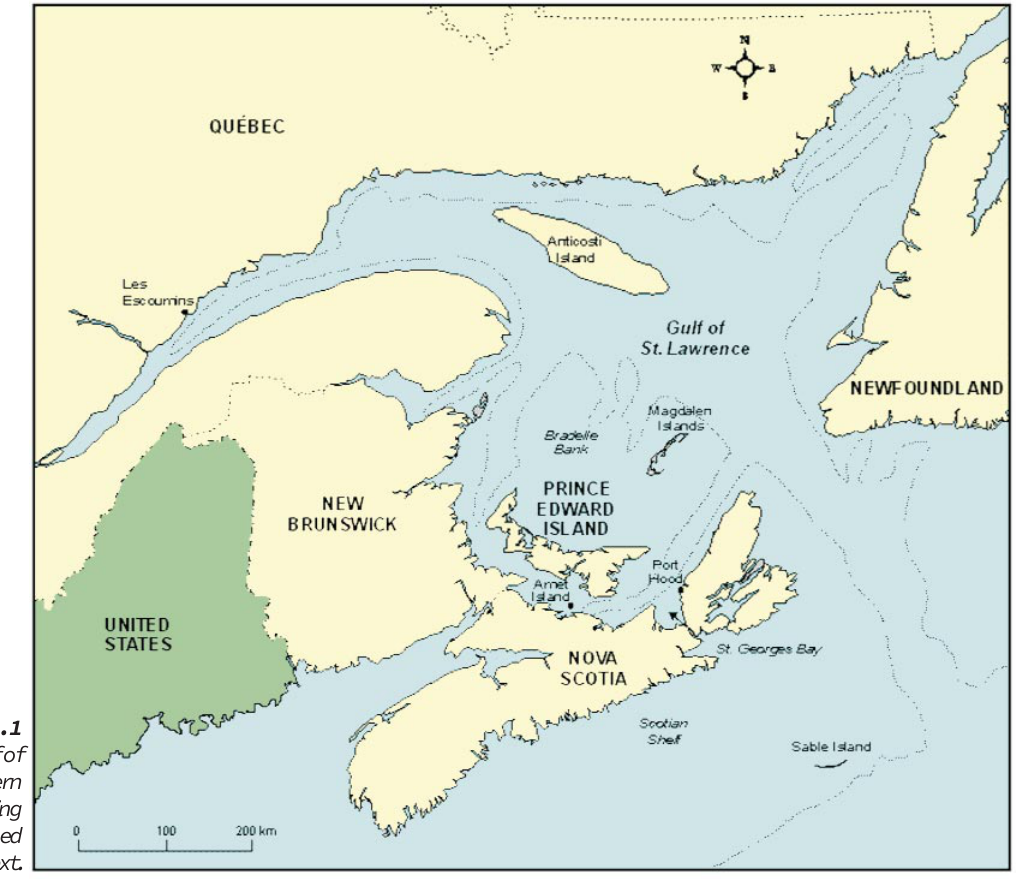
Sealworms in the North Atlantic : Ecology and Population Dynamics